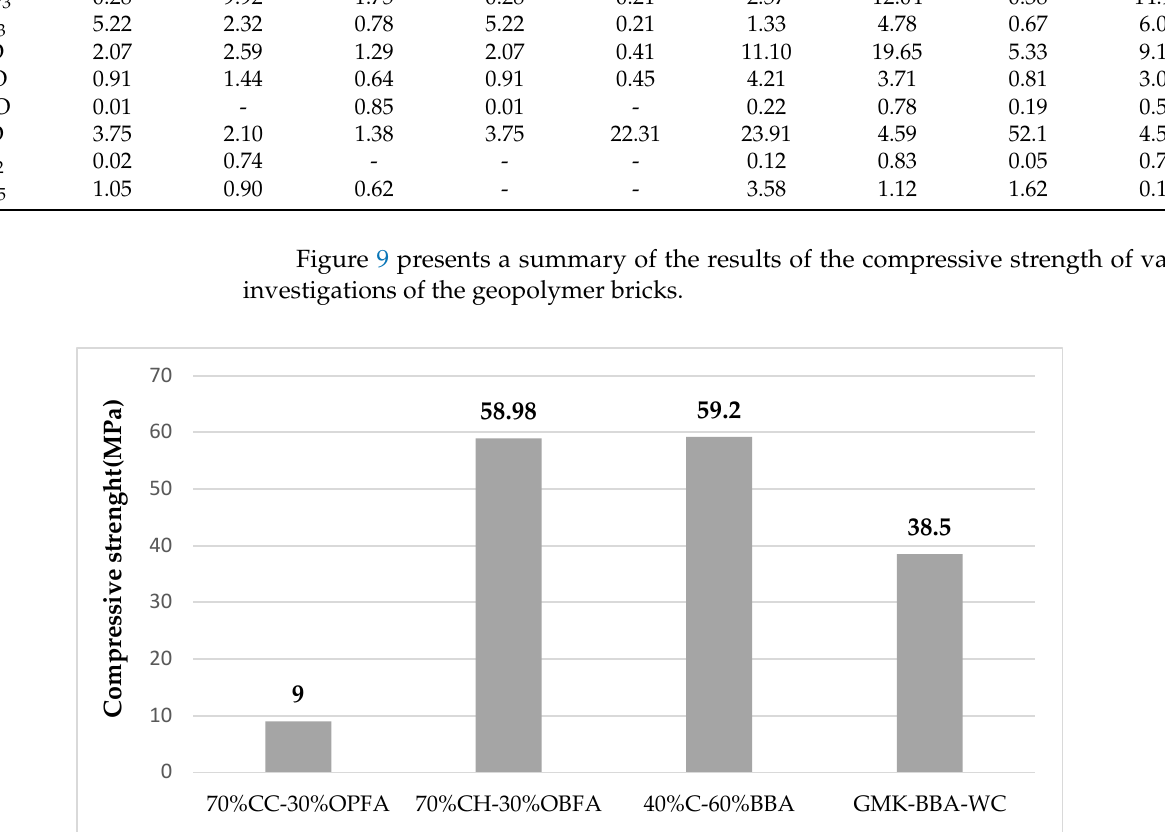
Figure 9. Compressive strength for geopolymer bricks: 70% CC-30% OPFA [88], 70% CH-30% OBFA [89], 40% C-60% BBA [90], GMK-BBA-WC [91].